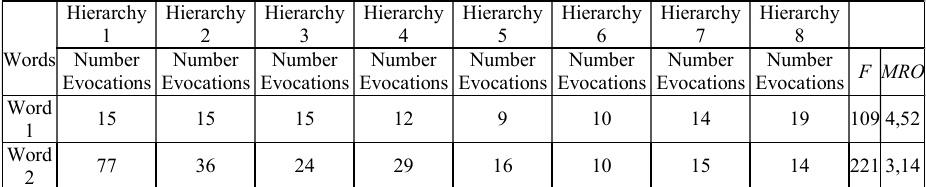
Table 1: Example, frequency calculation and MRO.